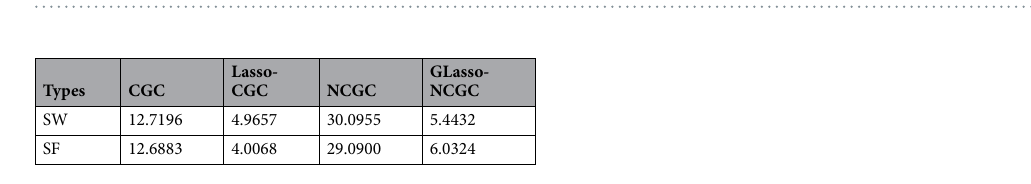
Table 5. The average computational time (in sec.) of different methods over 10 independent realizations in the simulation of GRN model on SW and SF